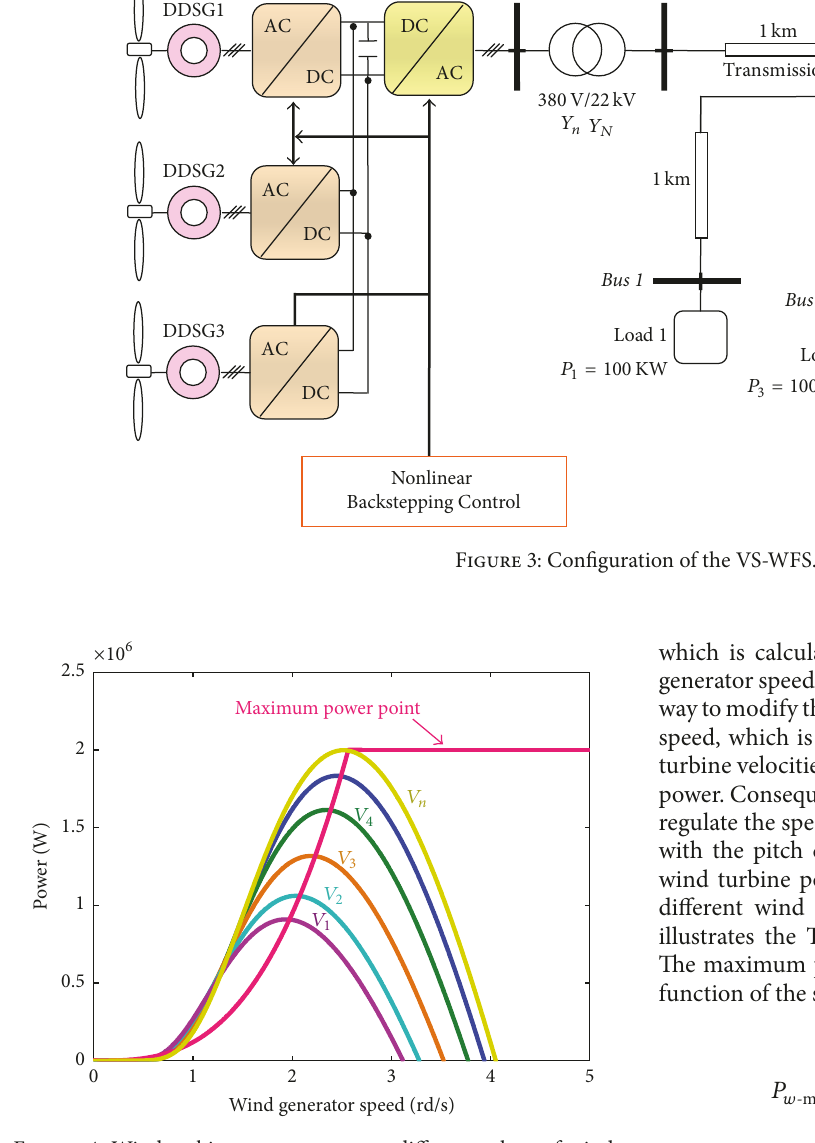
Figure 4: Wind turbine power curves at different values of wind